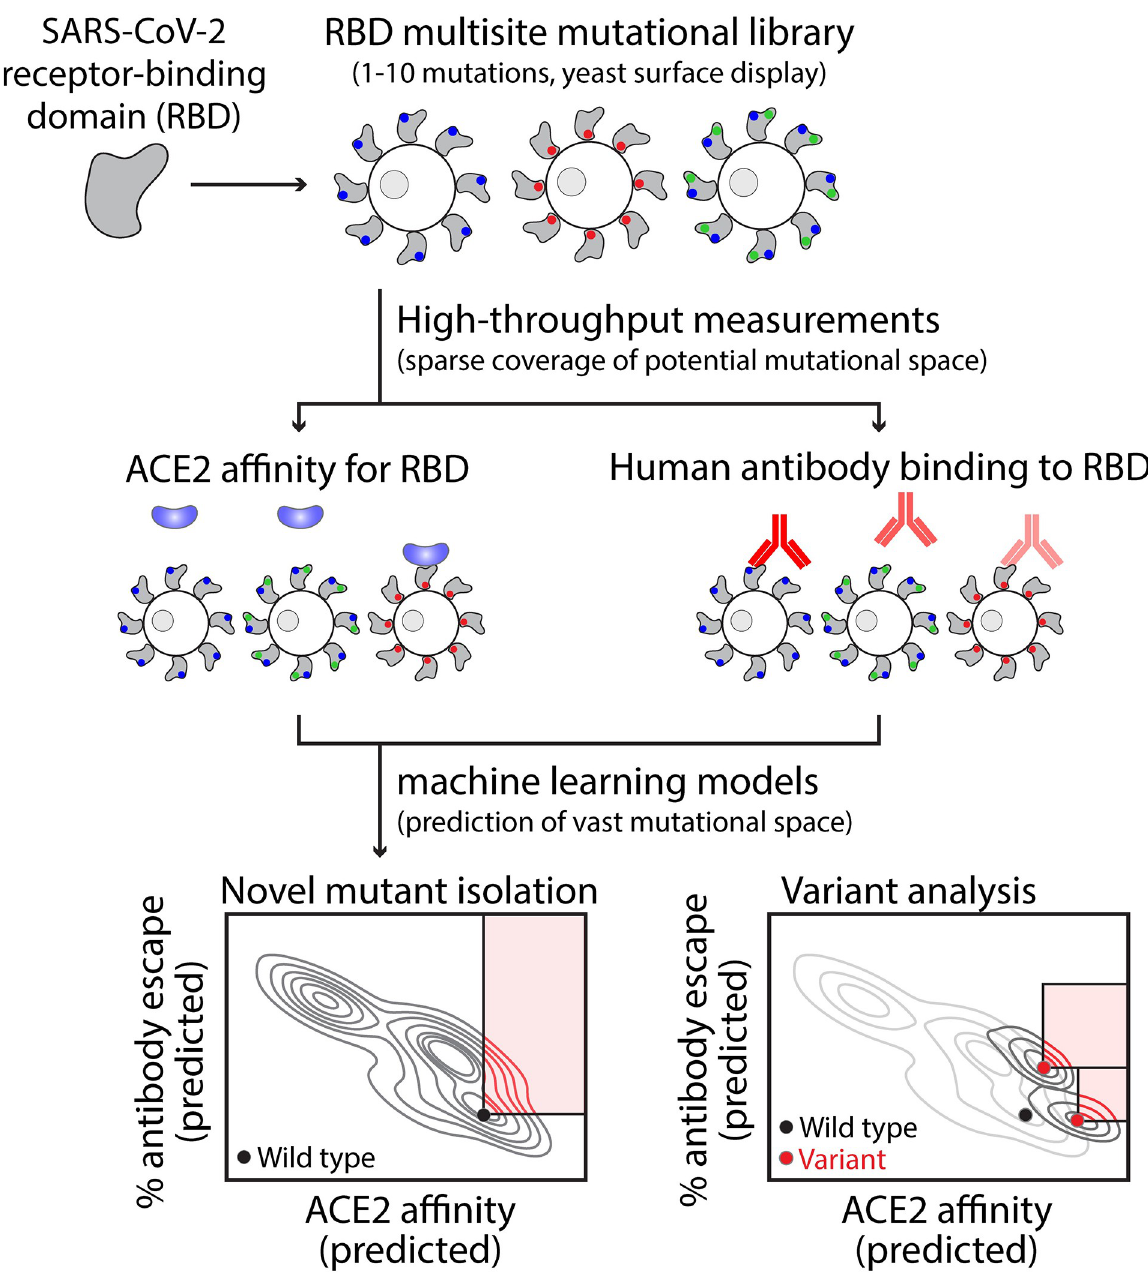
Fig 1. Overview of the development of machine learning models for predicting mutations in the receptor-binding domain of SARS-CoV-2 that increase transmissibility. Machine-learning models were trained and tested on large but sparsely sampled experimental datasets that characterize the impact of single and multisite RBD mutations on ACE2 affinity and human serum antibody binding ( > 100,000 RBD variants with 1–10 mutations). The relative binding levels of human serum antibodies to RBD mutants were converted into % human serum antibody escape values as 100% minus the % antibody binding to mutant RBD relative to wild-type RBD. It is important to consider the impacts of RBD mutations on both properties because ACE2 affinity strongly impacts viral infectivity and human antibody binding strongly impacts viral neutralization. The two models were employed to predict mutations, and combinations thereof, that increase ACE2 affinity, human serum antibody escape or both for the vast mutational space that is much larger than what is possible to evaluate using experimental methods. Mutations were identified that enhance transmissibility for wild-type SARS-CoV-2 as well as additional mutations that further enhance transmissibility of several current and former CDC Variants of Concern.